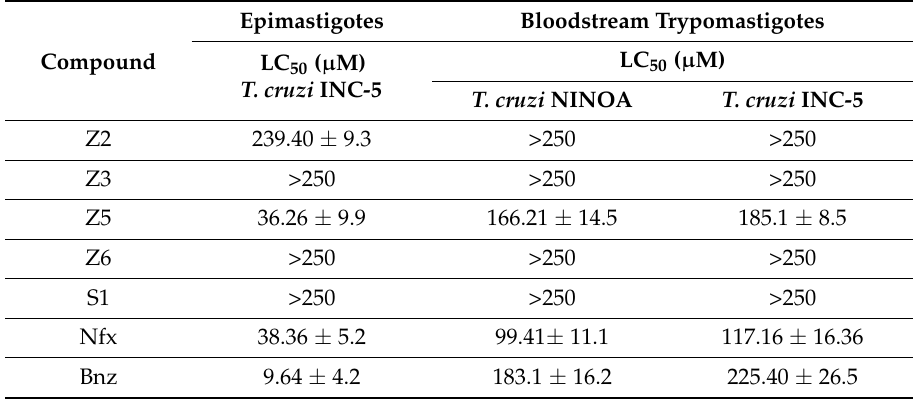
Figure 4. Amino acid interactions of the four (Z2, Z3, Z5 and Z6) selected compounds and the reference ligand 186 on Cz. In the five figures, arcs with red lines represent hydrophobic amino acid contacts, green dashed lines represent hydrogen bonds and purple lines represent covalent bonds between protein and ligand or “elastic” bonds within the ligand. The image was produced with LigPlot software. Table 2. Half maximal lytic concentration of the compounds Z2, Z3, Z5, Z6 and S1 and the reference drugs on epimastigotes and trypomastigotes of T. cruzi